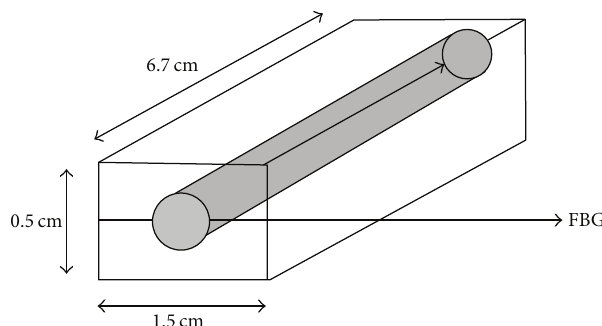
Figure 1: Schematic illustration of the FBG embedded in between two layers of